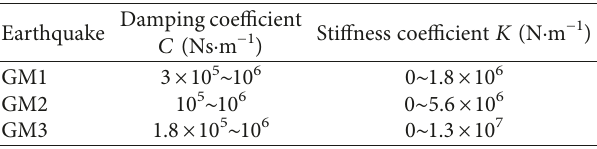
Table 5: Ranges of optimum parameters under earthquakes with different